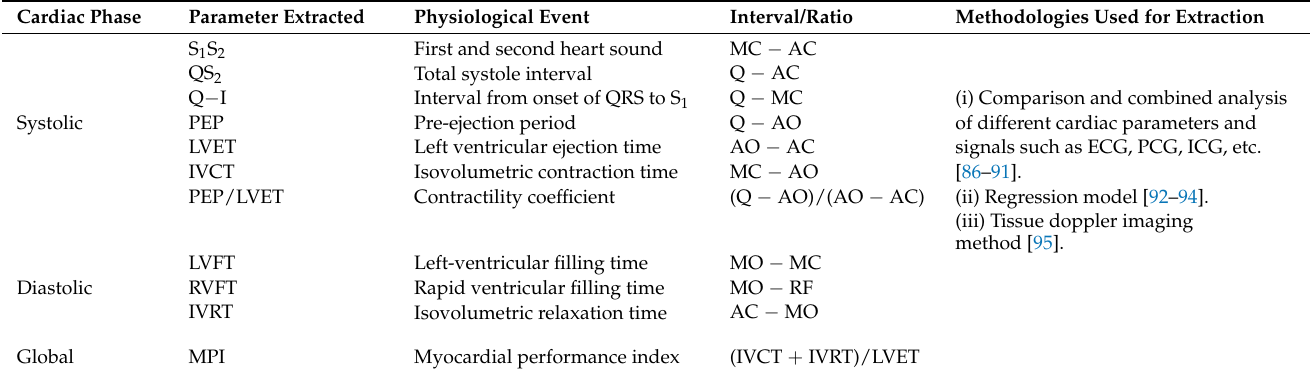
Table 5. Comparison of extracted